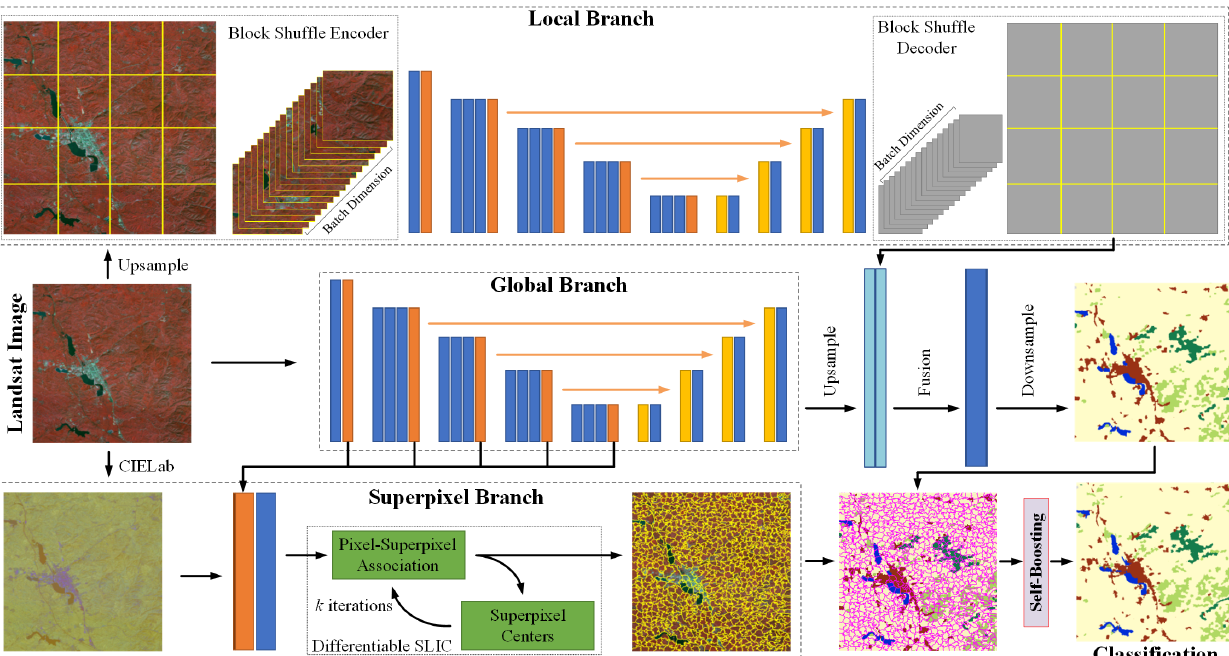
Figure 3. Overview of the block shuffle network (BSNet)